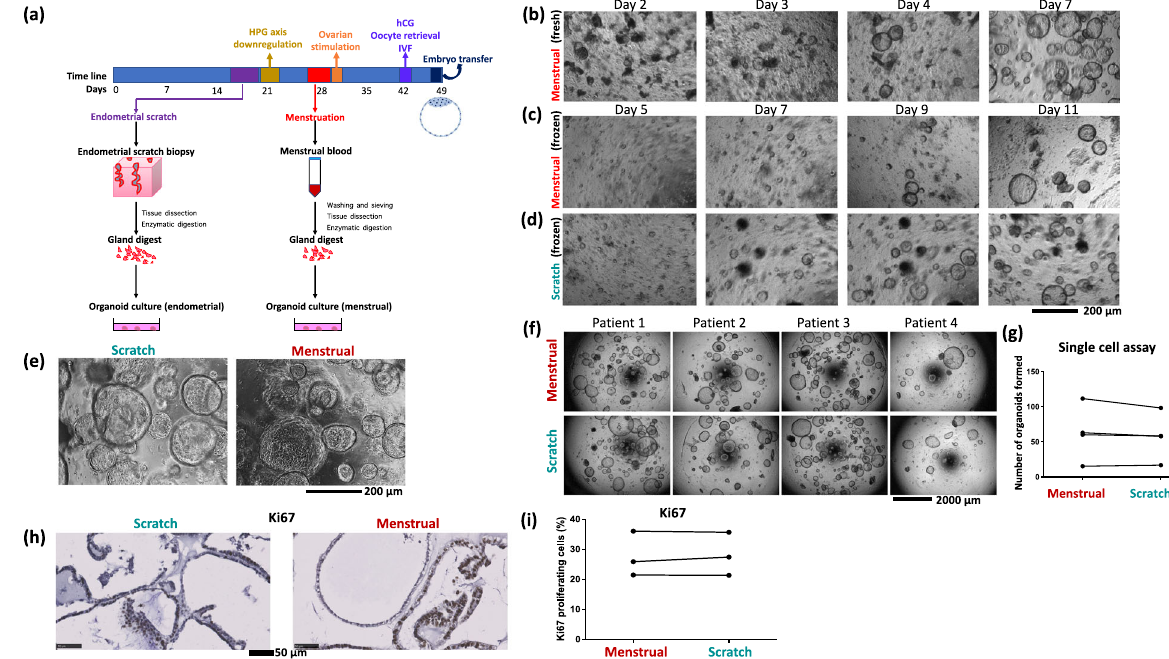
Fig. 1 Derivation and characterisation of menstrual fl ow organoids. a Schematic to illustrate how organoids were derived from an endometrial scratch and menstrual fl ow in the same cycle. b – d Time line images detailing propagation of organoids from menstrual fl ow and scratch. b The panel represents the growth of menstrual organoids directly derived from menstrual blood. c , d The panels illustrate the growth of organoids from frozen menstrual ( c ) and scratch ( d ) digests of the same patient. Scale bar 400 μ m. e Organoids derived from an endometrial scratch and menstrual fl ow of the same patient are indistinguishable morphologically. Scale bar 200 μ m. f , g Single-cell assay to compare the growth of paired menstrual vs. scratch organoids derived from four patients. Images show organoids seeded from single cells (5000 cells per 20 μ l drop Matrigel) after 9 days of growth ( f ). Quanti fi cation of the single- cell assay. Scale bar 2000 μ m. Five to 8-well repeats were quanti fi ed per condition ( g ). h Representative images of immunostaining against the marker